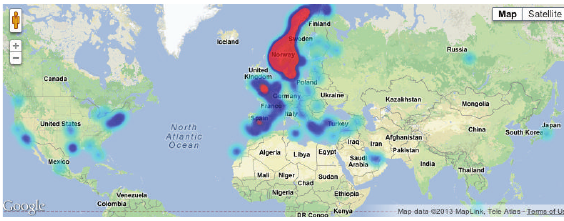
Figure 2: Heat-map of the geographical IP distribution in the world (the highest density of clients is in the red areas). There are also some clients in Russia and Japan outside the shown